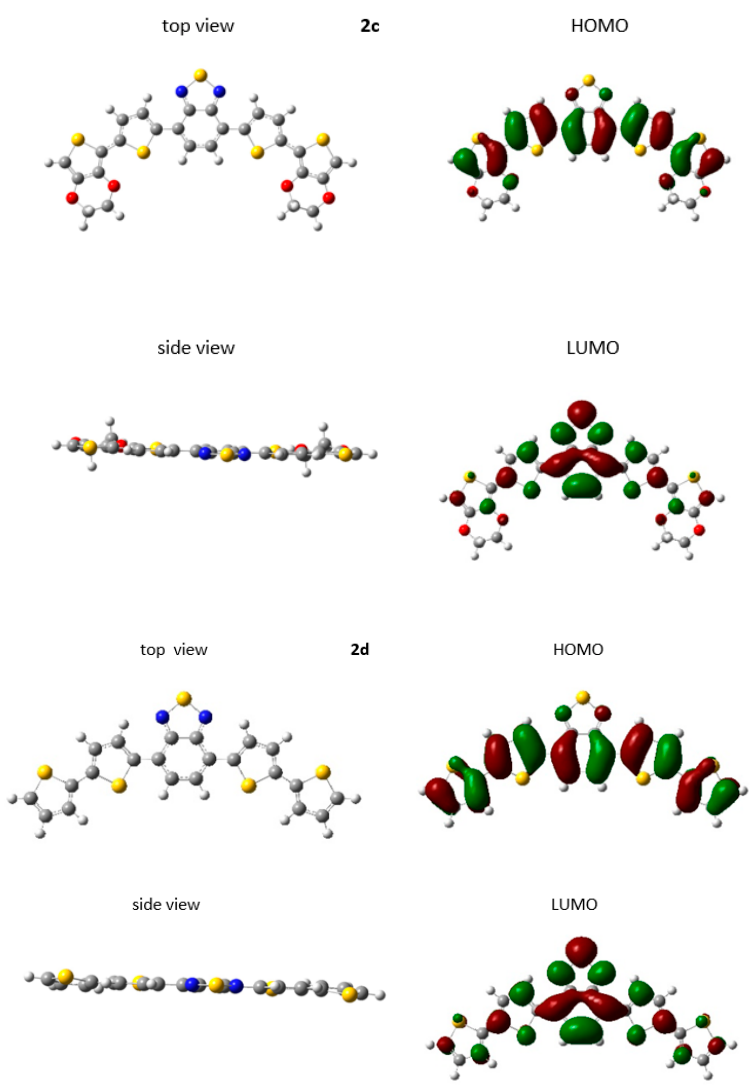
Figure 1. Optimized structures and Frontier molecular orbitals of 2a–d . Table 1. Redox properties of monomers. E ox onset —oxidation peak onset; E red onset —reduction peak onset; IP—ionization potential, estimated from the equation IP[eV] = |e|5.1 + E ox onset [V]; EA—electron affinity, estimated from the